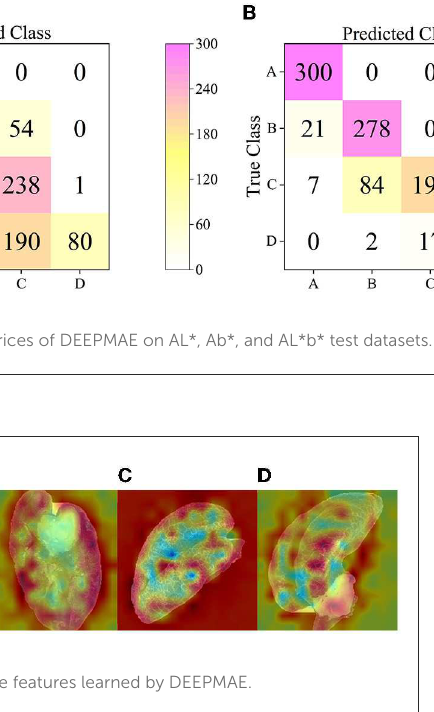
identifying D, VIT at identifying B, and slightly better than both for A and C. Compared to the backbone model DEEPMAE learns more critical distinguishing